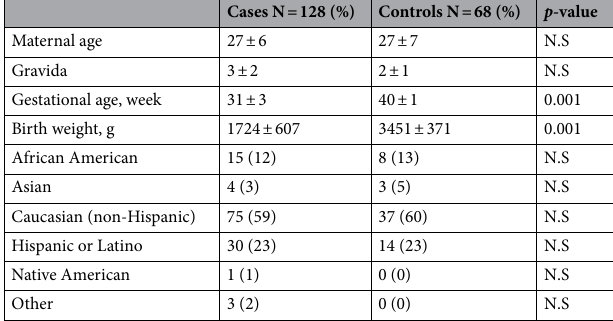
Table 1. Clinical characteristics of patients. Mean ± SD.